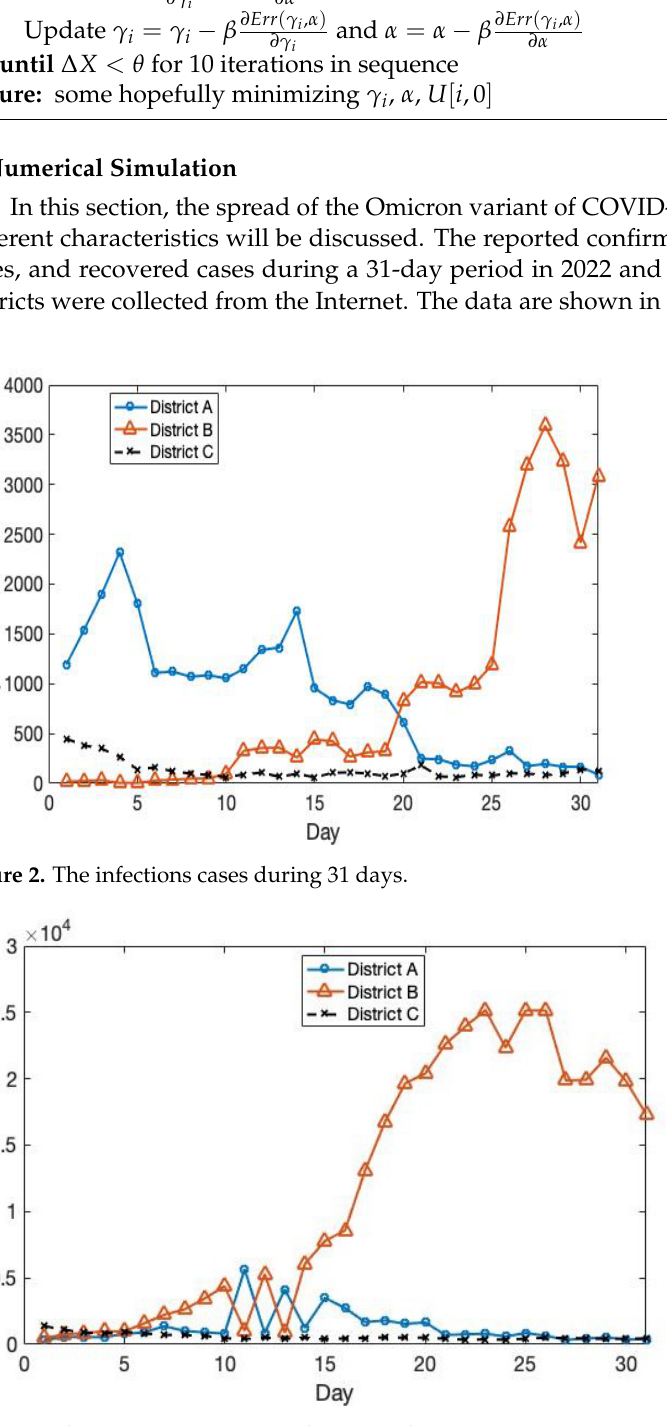
Figure 3. The asymptomatic cases during 31